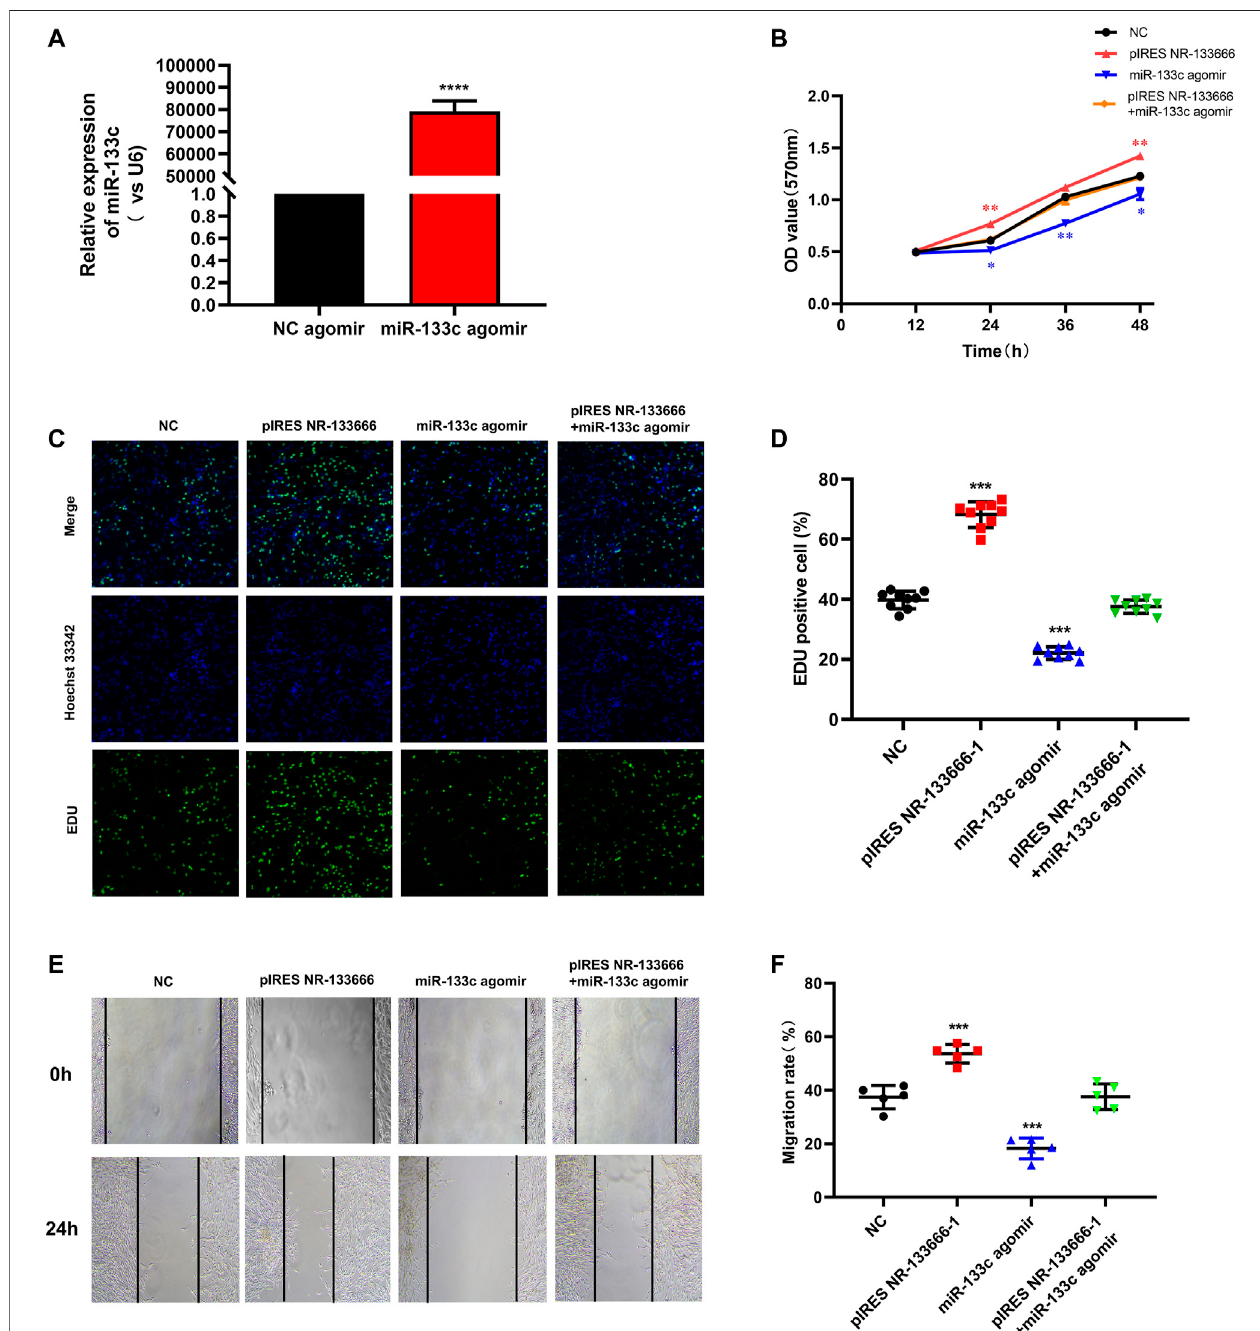
FIGURE5| .lncRNANR-133666regulatestheproliferationandmigrationofCIAFLSbyregulatingmiR-133c. (A) qRT-PCRshowedthatmiR-133cwasincreased in miR-133c agomir-transfected CIA FLS. (B) MTT was performed to verify the effect of miR-133c overexpression, NR-133666 overexpression and co-expression groups on CIA FLS proliferation. (C,D) EdU assay showed CIA FLS proliferation after transfecting pIRES NR-133666, miR-133c and pIRES NR-133666 +miR-133c groups (100×). (E,F) woundhealingassayshowedthemigratory abilityofCIA FLScells(100×).Comparedwithcontrols,* p < 0.05, ** p < 0.01,*** p < 0.001,**** p <